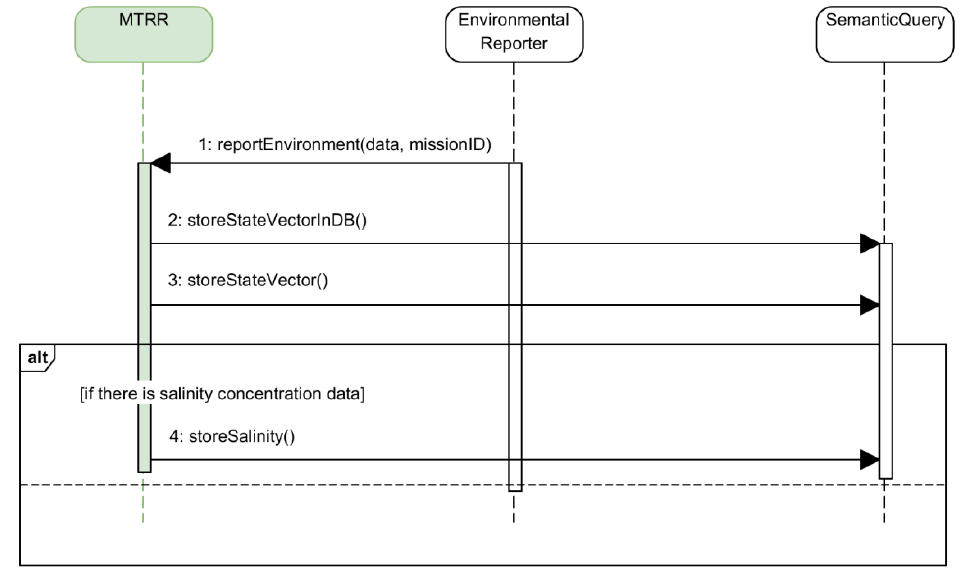
Figure 19. Sequence diagram for the management of an environment report.